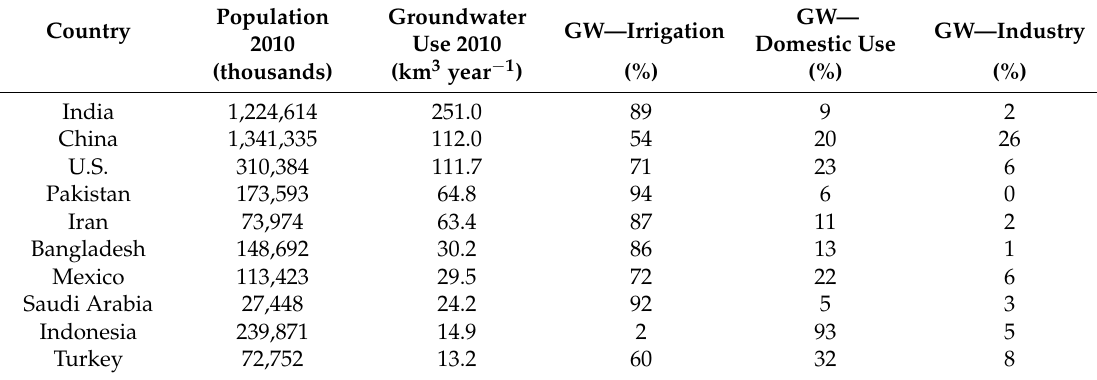
Table 1. Ten countries with the highest estimated groundwater (GW) extraction (Source: National Ground Water Association